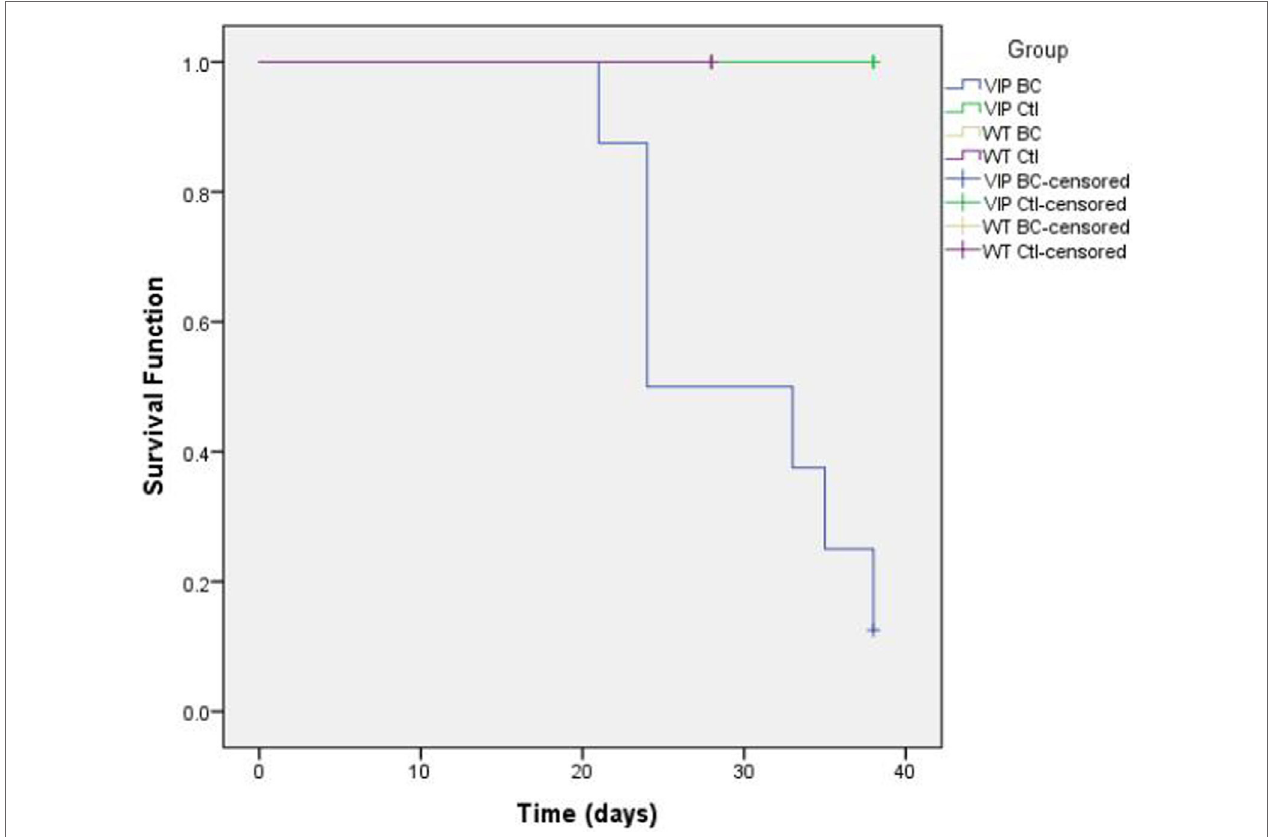
FigUre 2 | Kaplan–Meier plot comparing death rates between vasoactive intestinal peptide knockout (VIP KO) controls, VIP KO mice with MB49, C57BL/6 controls, and C57BL/6 mice with MB49 ( p = 0.002).